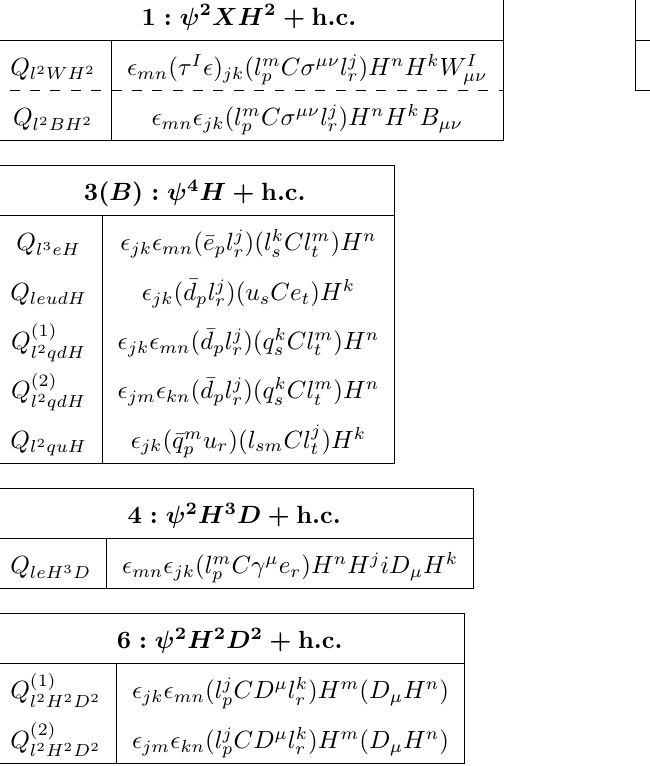
Table 20 . The dimension-seven operators in the SMEFT. The operators are divided into six classes according to their (cid:12)eld content. The classes-3 and -5 are further divided into subclasses according to their baryon number. All of the operators have Hermitian conjugates. The subscripts p; r; s; t are weak-eigenstate indices. Operators below the dashed lines in classes-1 and -3 vanish when there is only one generation of